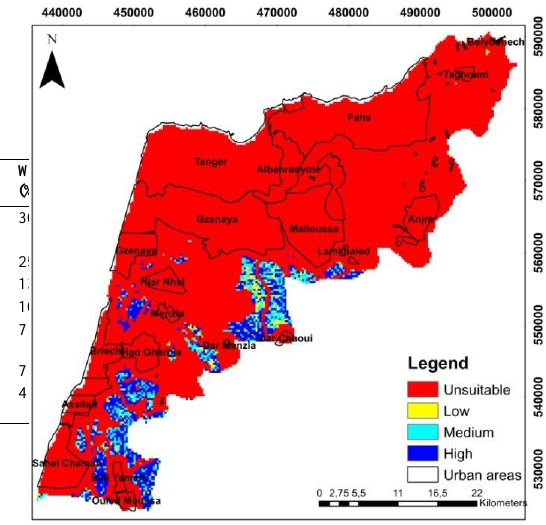
Figure 4. Land suitability for PV power